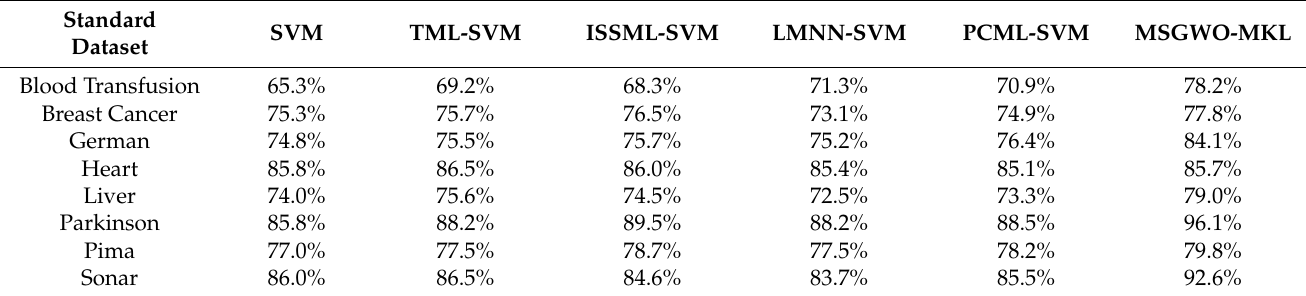
Table 3. Classification